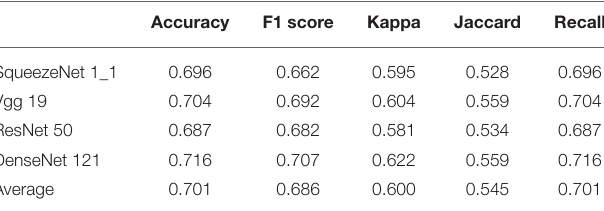
TABLE 3 | Results of fundus